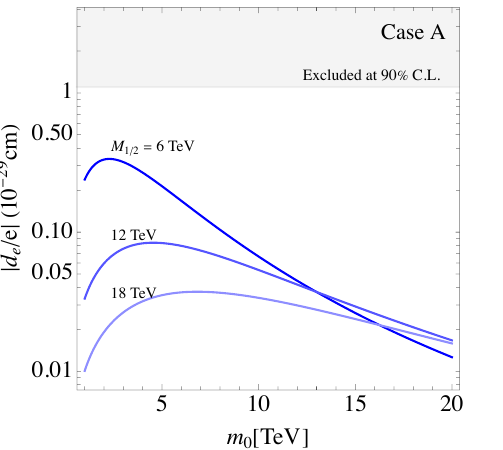
Figure 2 . The predicted BR( µ → eγ ) versus m 0 with putting F τ = m 0 / 2 in case A. The grey region is excluded by the experimental up- per